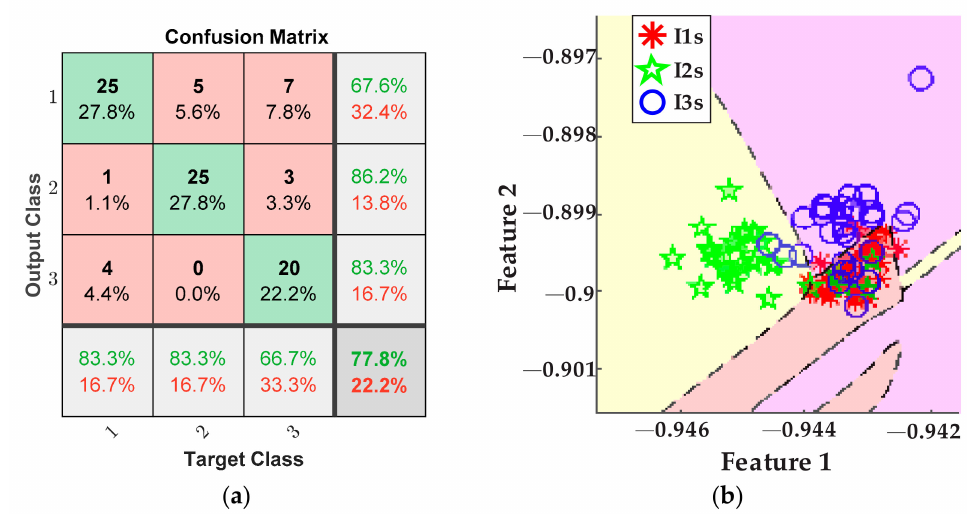
Figure 12. Results from cutting speed variations for the AC current sensor; ( a ) confusion matrix and ( b ) ANN classification.